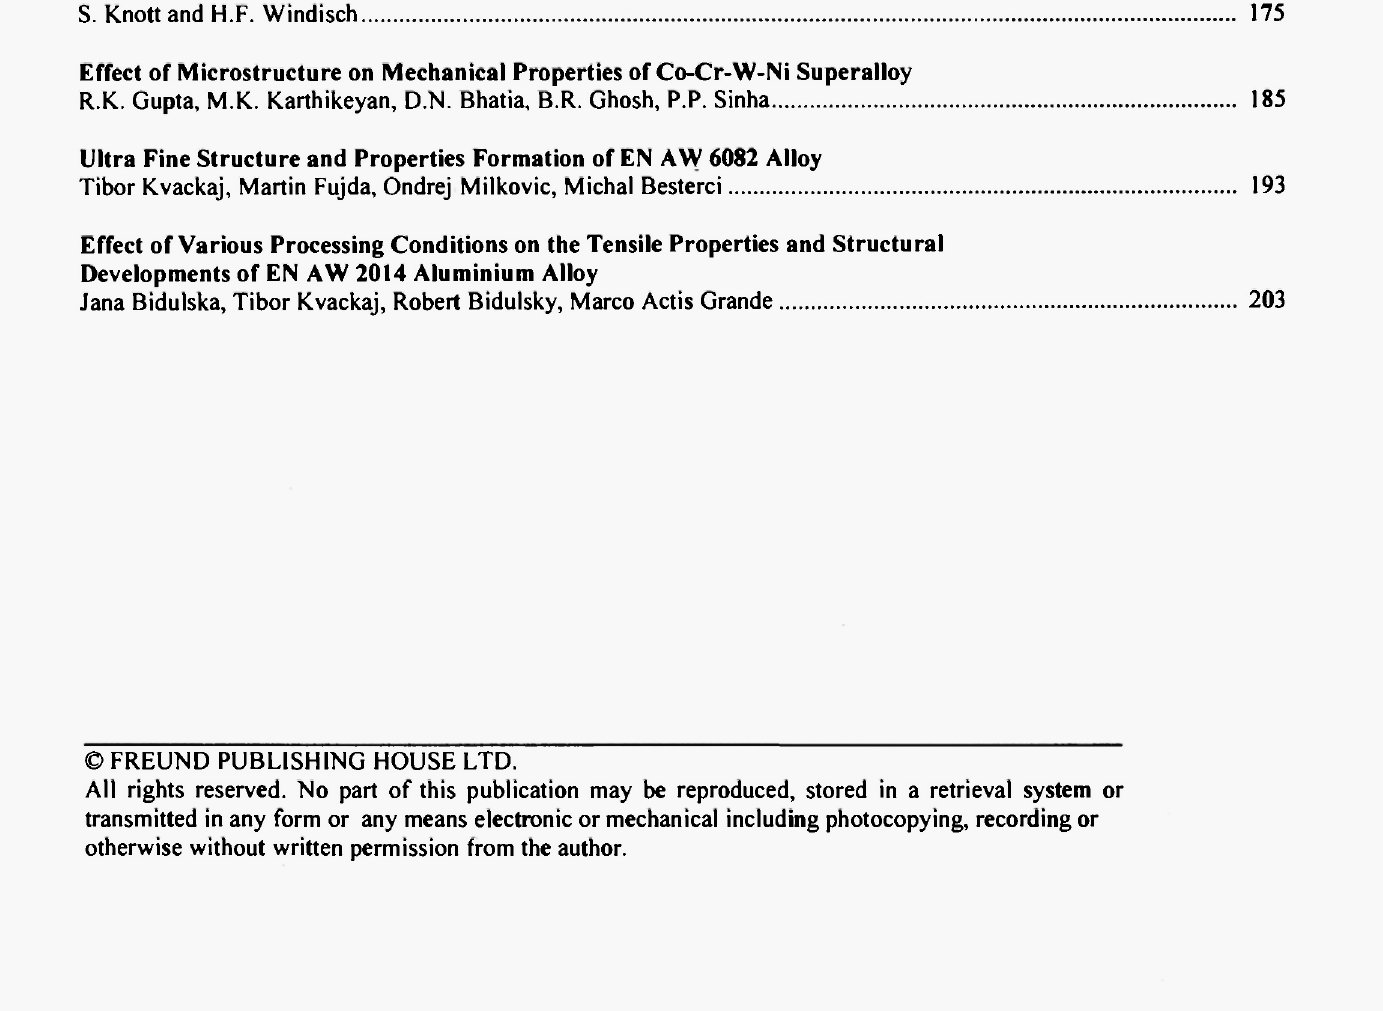
Structural and Dielectrical Properties of Mn0 2 -V 2 05-Sn0 System at 1023